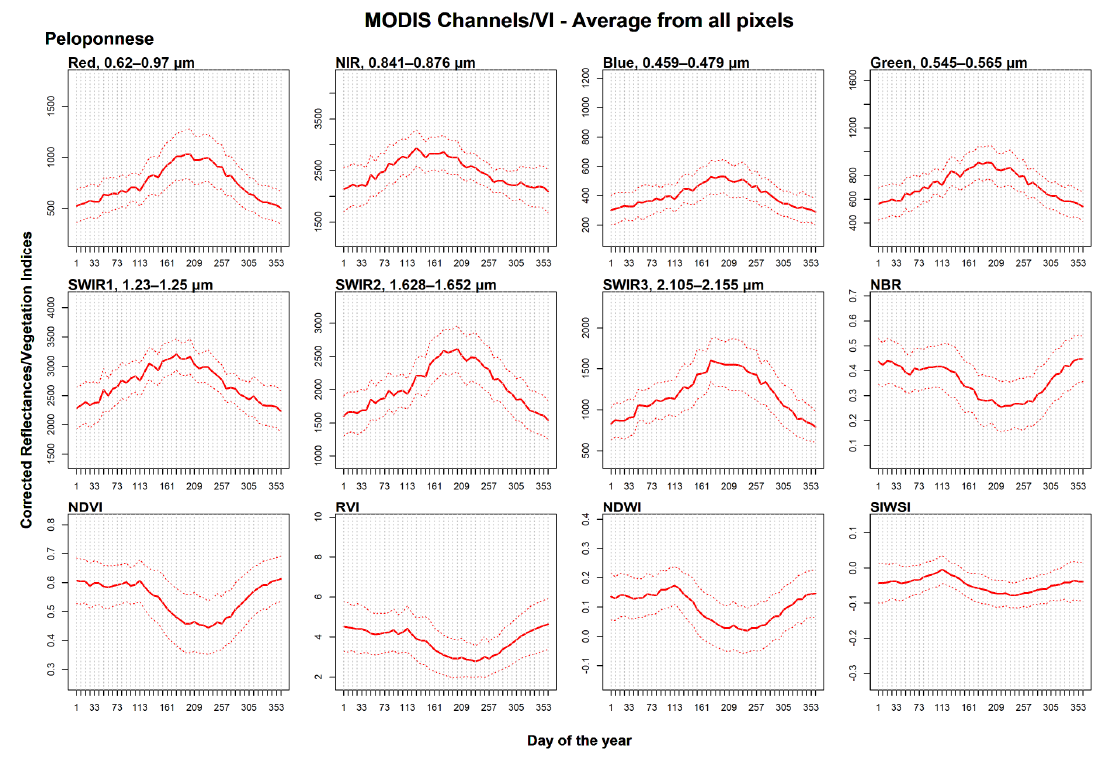
Figure 11. Phenology profiles using the 8 day time intervals provided by the MODIS 8-days composites, showing specific patterns of the vegetation before the fire in the fire-affected areas.